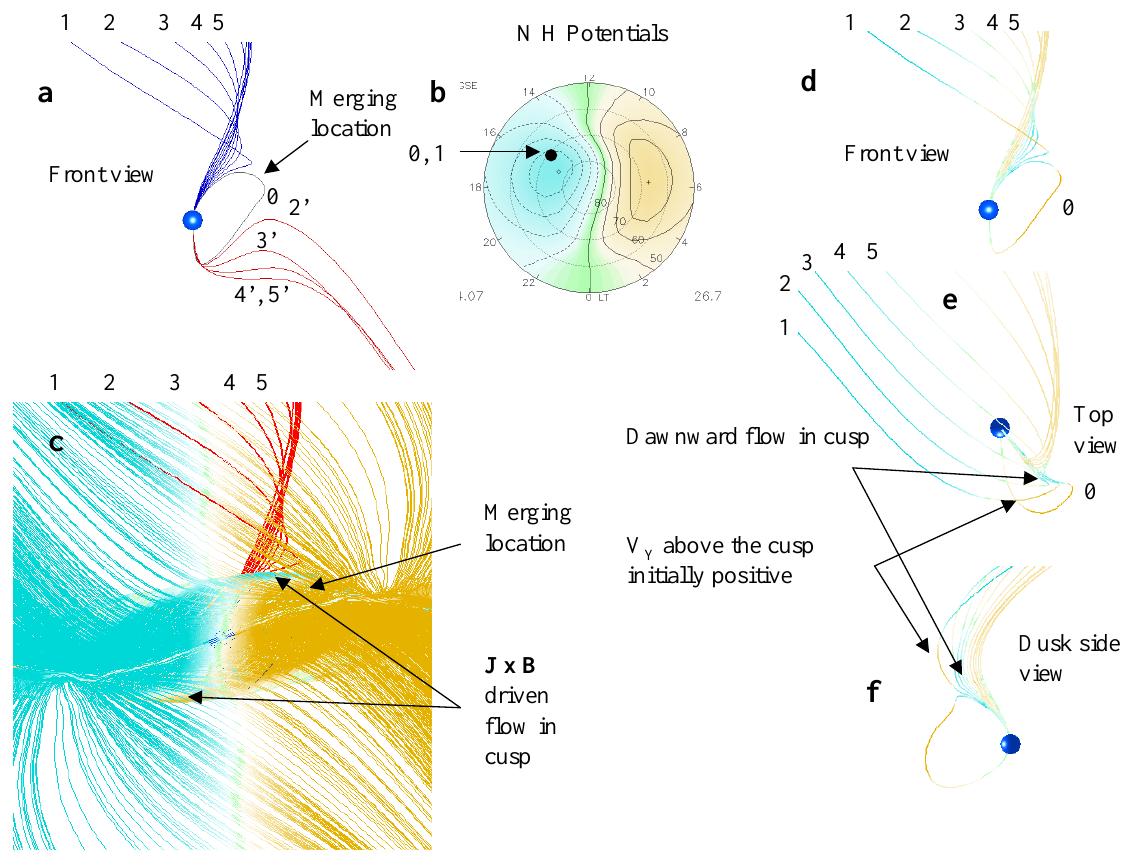
Figure 2 Fig. 2. Traced magnetic field lines from a MHD simulation using the Integrated Space Weather Model (ISM). Figure 2a shows a set of field lines flowing away from a high-latitude merging site. Trace 0 is closed, and its origin in the Northern Hemisphere is shown in Fig. 2b to be between 15 and 16MLT and 71 ◦ latitude. All others are open. Figures 2d–f show three views of these same field lines colored with the Y component of the velocity. Figure 2c shows the complete set of first-open field lines traced from the ionosphere in each hemisphere and also colored with V Y (see